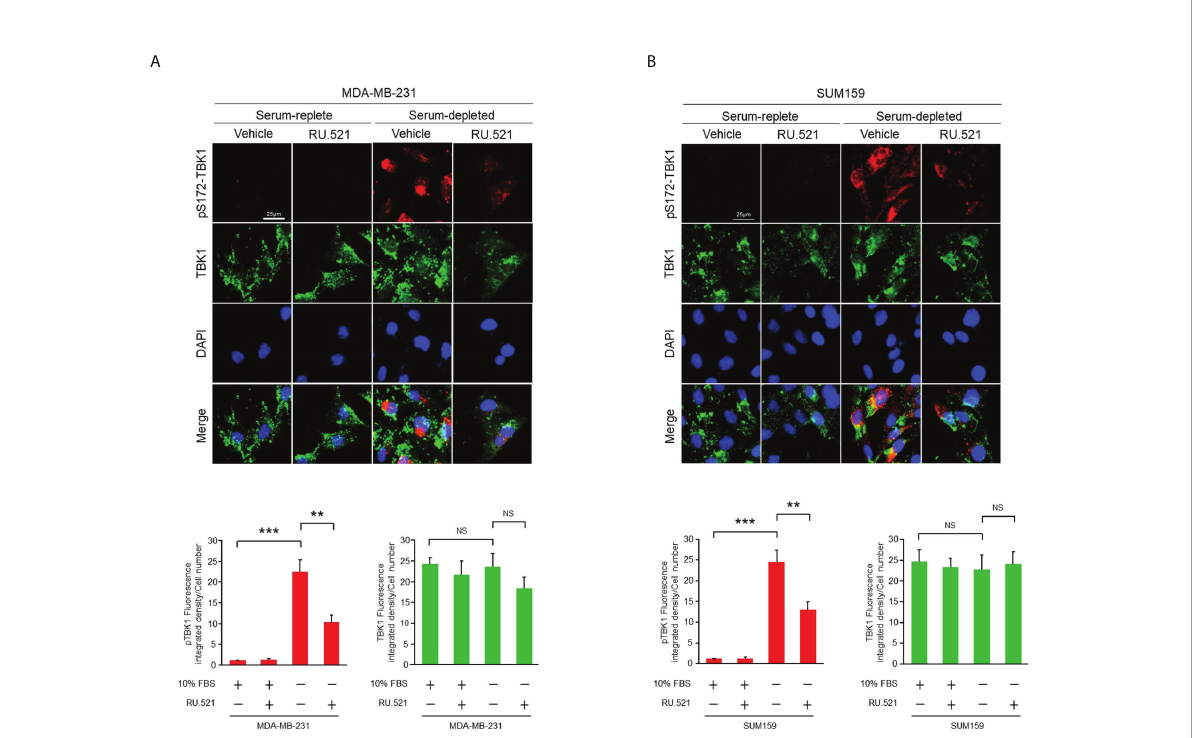
FIGURE 2 The cGAS-STING pathway of TNBC cells was activated by serum depletion which was suppressed by treatment with RU.521. MDA-MB-231 cells (A) and SUM159 cells (B) were grown in normal or serum-depleted media in the presence or absence of RU.521 (10 m M) for 24 hr. Total TBK1 and pSer172 TBK1 were detected by immuno fl uorescence staining with the corresponding antibodies. Fluorescent images were captured at 630x magni fi cation. The nuclei were counterstained by DAPI. Bar, 25 m m. The images were quantitated and plotted with three independent results are shown as means ± SD, and the statistical signi fi cance was calculated by Student ’ s t-test. **, p < 0.01, ***, p < 0.001. NS, non-signi fi cant with the p values greater than